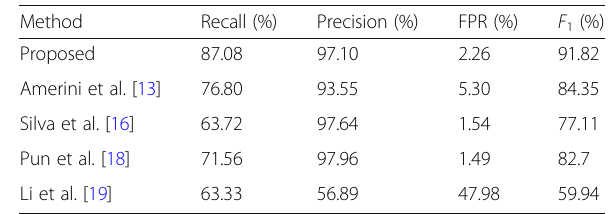
Table 6 Detected results for CMH3 dataset under resizing